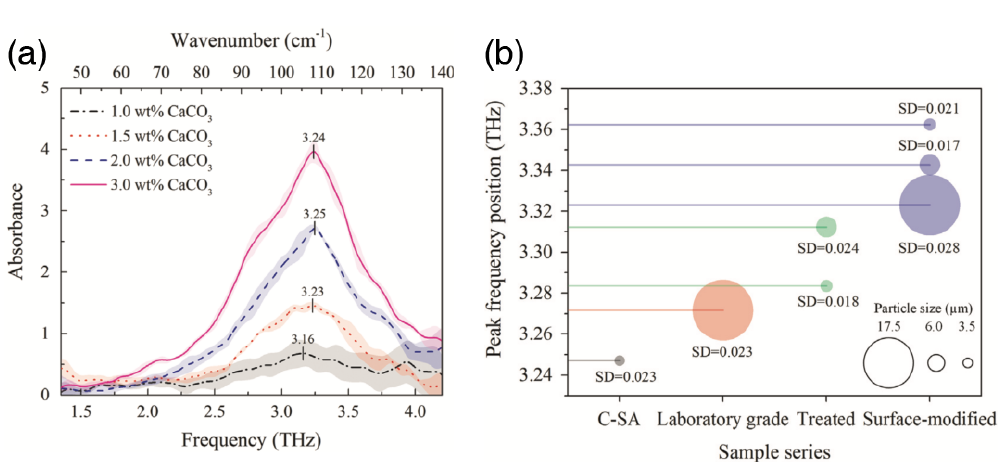
Figure 15. ( a ) THz spectra of various concentrations of CaCO 3 in a polyethylene (PE) matrix; ( b ) peak frequency position of pure calcite (C-SA) in comparison with natural calcite of laboratory grade, calcite treated with additives and surface-modified calcite powders. The different size of particles is presented by circles of varying diameter and the error in the peak position is presented by a value of standard deviation (SD) next to each circle [174]. Reprinted from Ref. [174] with permission from